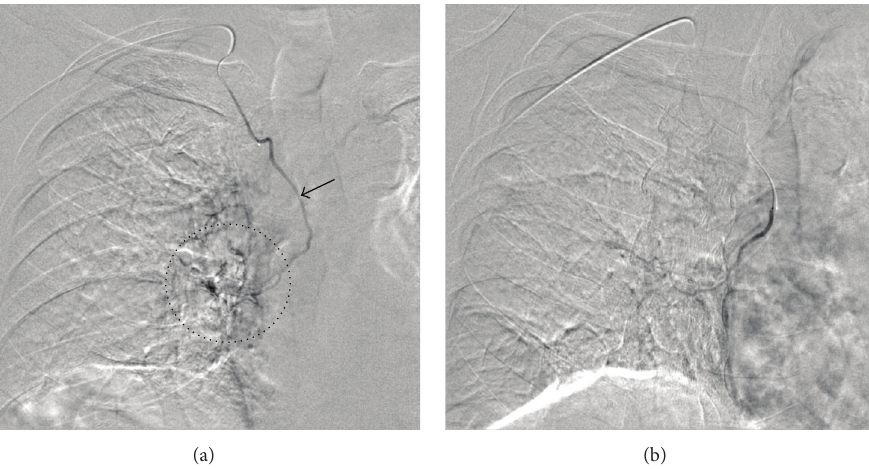
Figure 3: (a) Selective angiogram of the aberrant right bronchial artery (arrow) shows parenchymal staining in the right lower lobe (dotted circle). (b) The parenchymal staining disappeared after embolization with absorbable gelatin sponge.